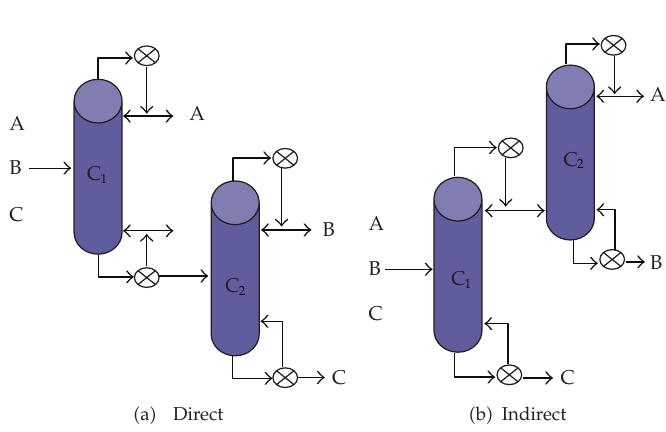
Figure 7: Conventional distillation sequences for the separation of ternary mixtures (cid:4) 17 (cid:5) .